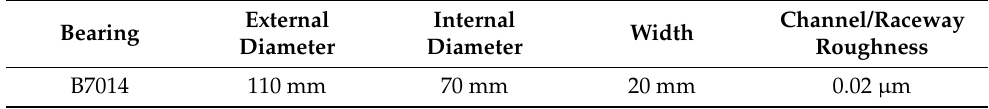
Table 1. Technical indicators of P2-grade angular-contact 7014 ball bearing.